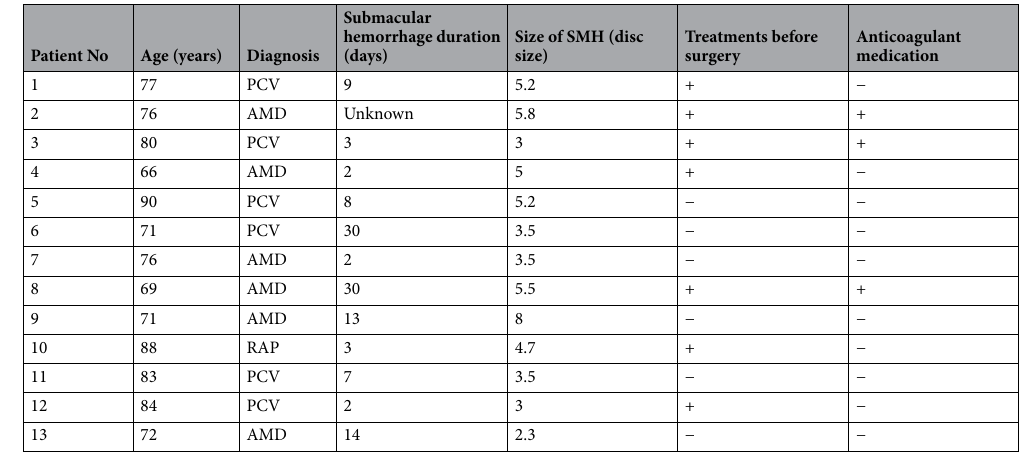
Table 1. Demographic